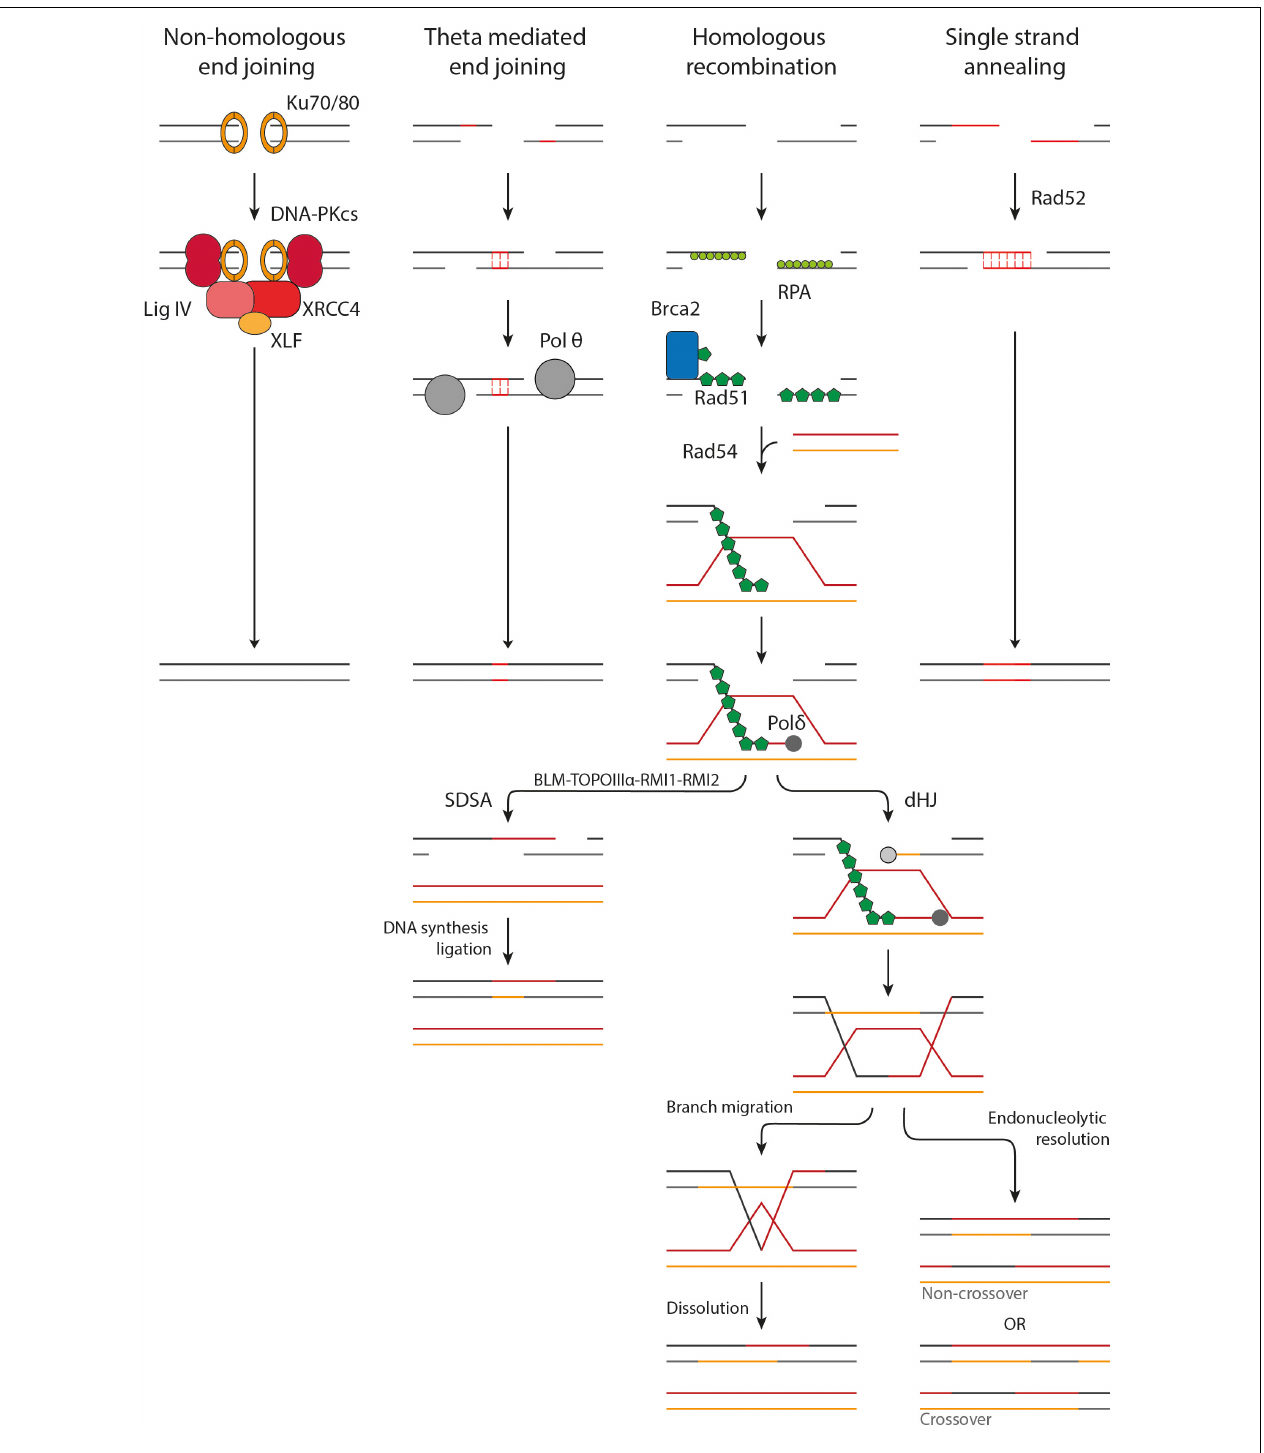
FIGURE 2 | Overview of the DSB repair pathways. NHEJ acts upon protected DSB ends. Ku70/80 binds to the DSB ends followed by the accumulation of DNA-PKcs, XRCC4, XLF, and LigIV. The DSB ends are processed and ligated. TMEJ acts on short-range resected ends. Microhomology of 2–20 bp is required to transiently align the DSB ends, after which the gaps are filled in by Pol θ . HR requires long-range resection and makes use of a homologous donor sequence for repair. After resection Rad51-loading onto the ssDNA is mediated by BRCA2. Homology search is facilitated by Rad54. Once a homologous donor strand has been found a D-loop is formed and DNA synthesis is started. In SDSA the D-loop is disrupted, followed by DNA synthesis and ligation to repair the DSB. A D-loop can also progress into the formation of a dHJ, which can be resolved by branch migration and dissolution or endonucleolytic resolution. Endonucleolytic resolution can result in a non-crossover or crossover